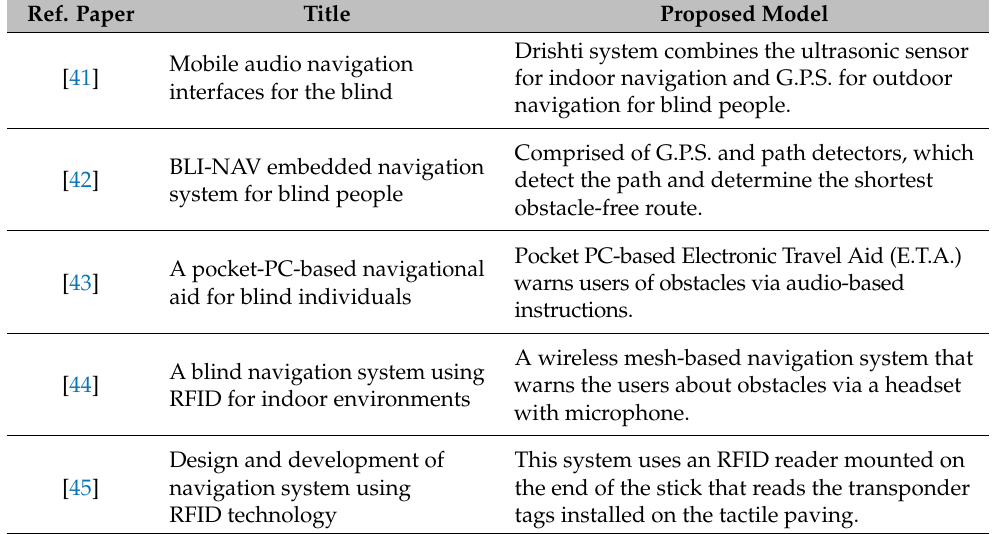
Table 5. Summary of Various RFID-Based Navigation Tools. Ref. Paper